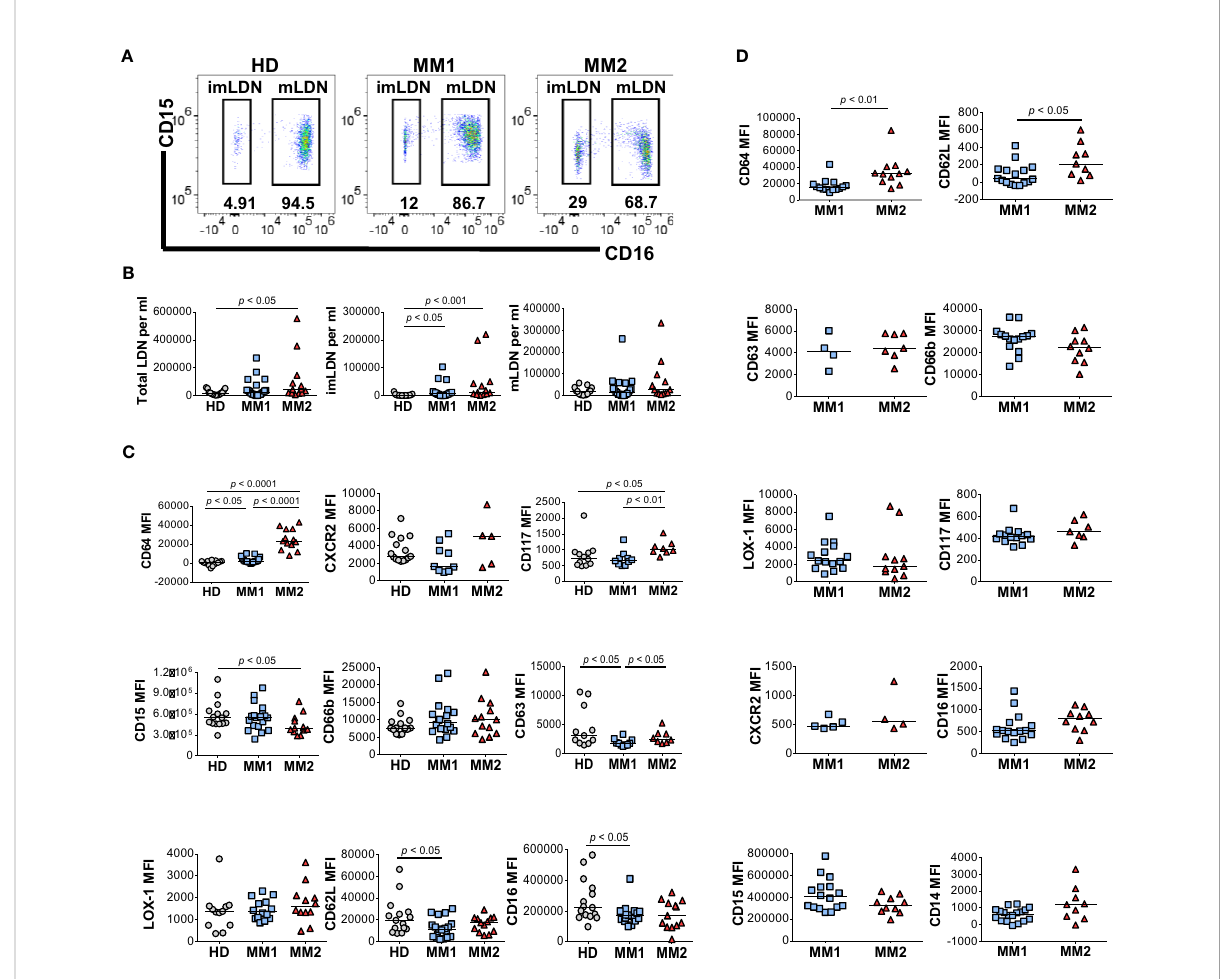
FIGURE 2 Distinct phenotypes on low-density neutrophils obtained from MM1 and MM2 patients. (A) Representative cytograms of CD15 + CD16 + mature low-density neutrophils (mLDNs) and CD15 + CD16 - immature low-density neutrophils (imLDNs). (B) Frequencies of total LDNs, mLDNs, and imLDNs in the blood of HD, MM1, and MM2 patients. (C, D) Surface expression of maturation, degranulation, and activation markers on mLDNs (C) and imLDNs (D) from MM1, and MM2 patients. MFI, median fl uorescent intensity; statistical analyses were performed using the Mann- Whitney rank-sum test with p values indicated. Bars represent median